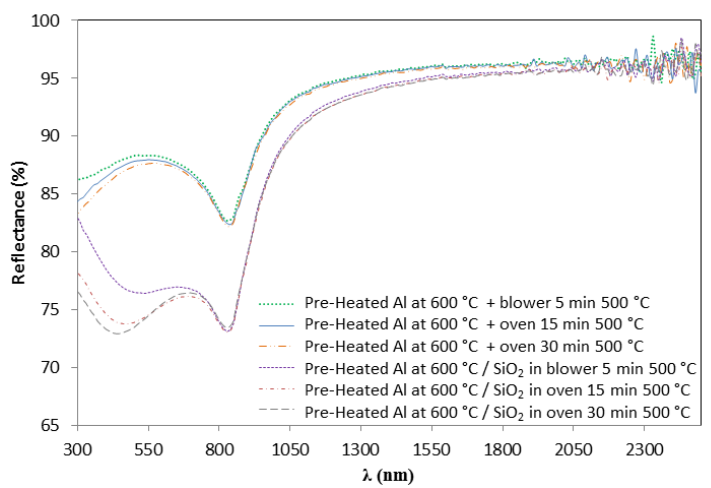
Figure 13. Effect of SiO 2 sintering conditions on both preheated bare Al and Al/SiO 2 on the hemi- spherical reflectance spectra. Table 6. Solar reflectance data after each degradation interval during the condensation test at 40 °C. Data correspond to preheated Al/SiO 2 samples at different sintering conditions.